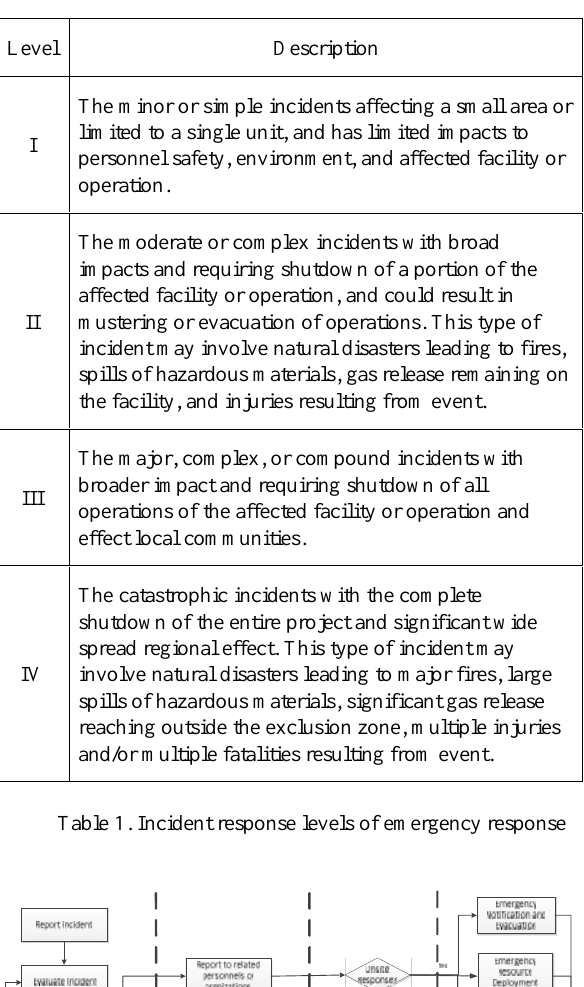
Figure 4 is simplified diagram of incident emergency response process.